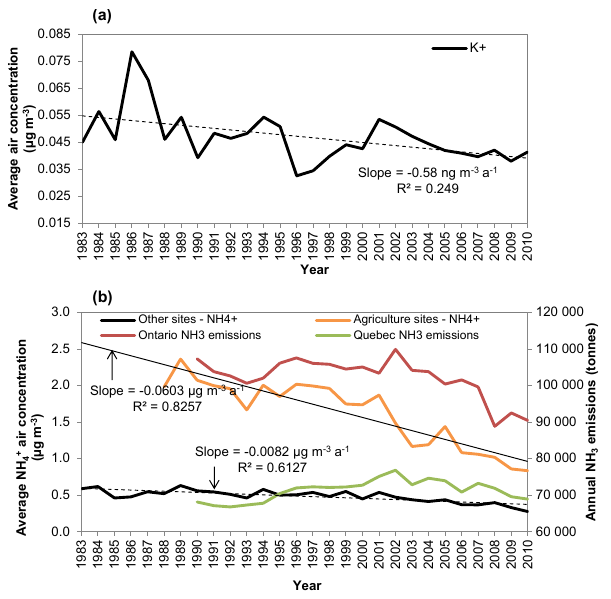
Figure 2. Temporal trends of annual average atmospheric K + (a) and atmospheric NH + and annual ammonia emissions (b) . In 4 panel (b) between 2002 and 2010, atmospheric NH + at agricultural 4 sites decreased by 6.3% while ammonia emissions in Ontario and Québec decreased by 2.4 and 1.1%, respectively.